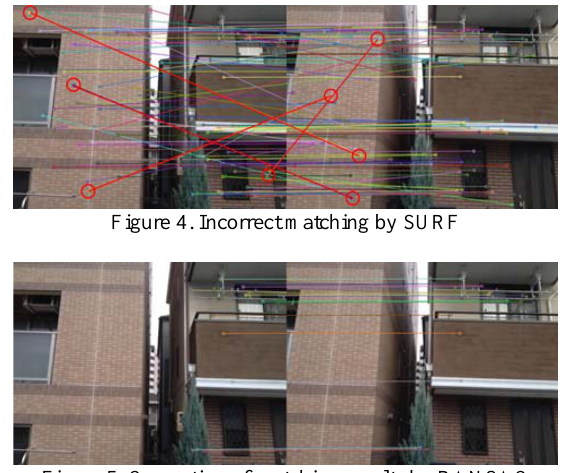
Figure 5. Correction of matching results by